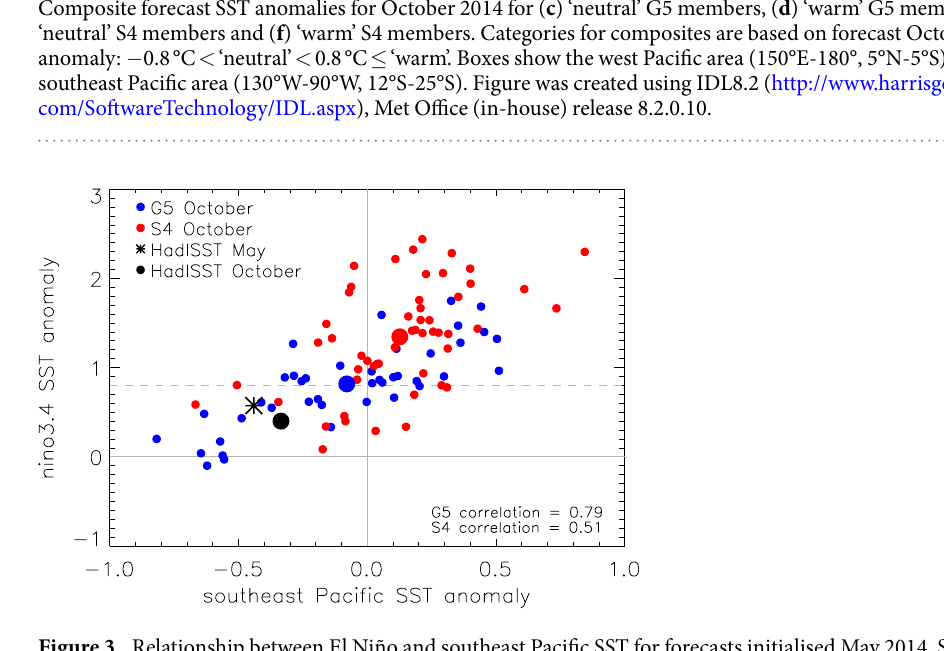
Figure 3. Relationship between El Niño and southeast Pacific SST for forecasts initialised May 2014. Scatter diagram of forecast ensemble members showing October 2014 Niño3.4 anomaly against October 2014 southeast Pacific SST anomaly for G5 (blue circles) and S4 (red circles). Ensemble means are large circles. Observations for May 2014 (black star) and October 2014 (black circle) are HadISST1.1. The dashed grey line indicates the 0.8 °C threshold. The southeast Pacific area (130°W-90°W, 12°S-25°S) is shown in Fig.